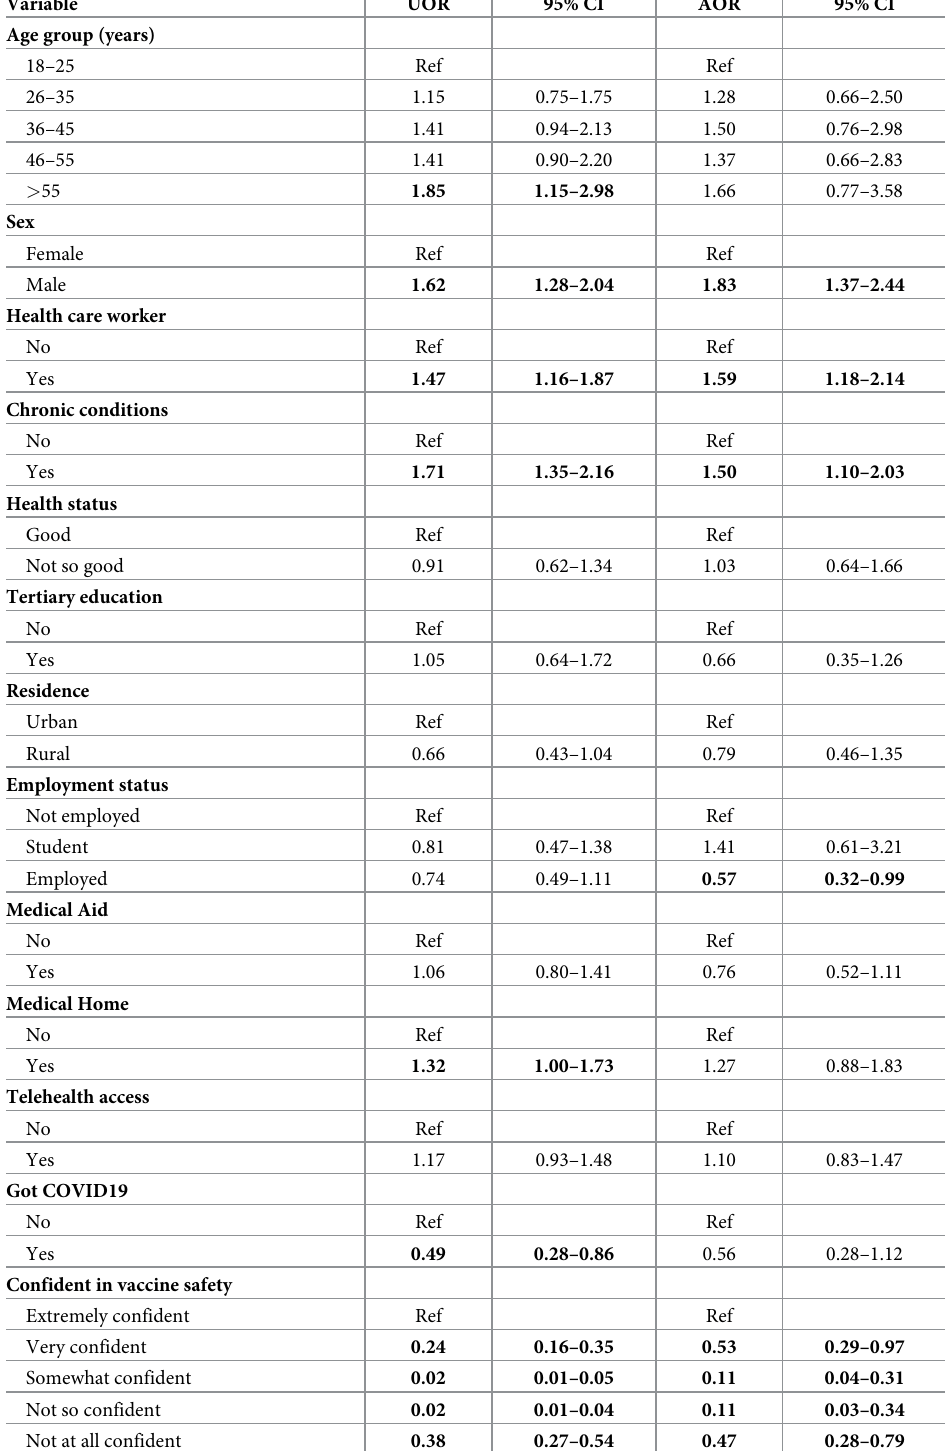
Table 2. Bivariate and multivariable logistic regression analysis—Predictors of vaccine uptake in study